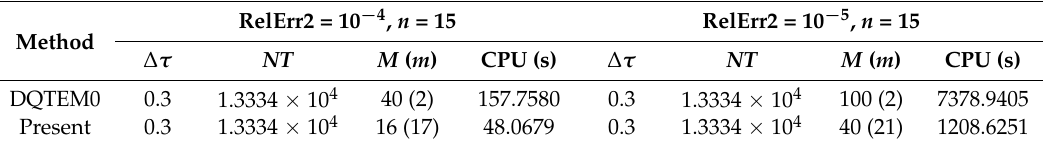
Table 9. Efficiency comparison of the improved DQTEM and DQTEM0.